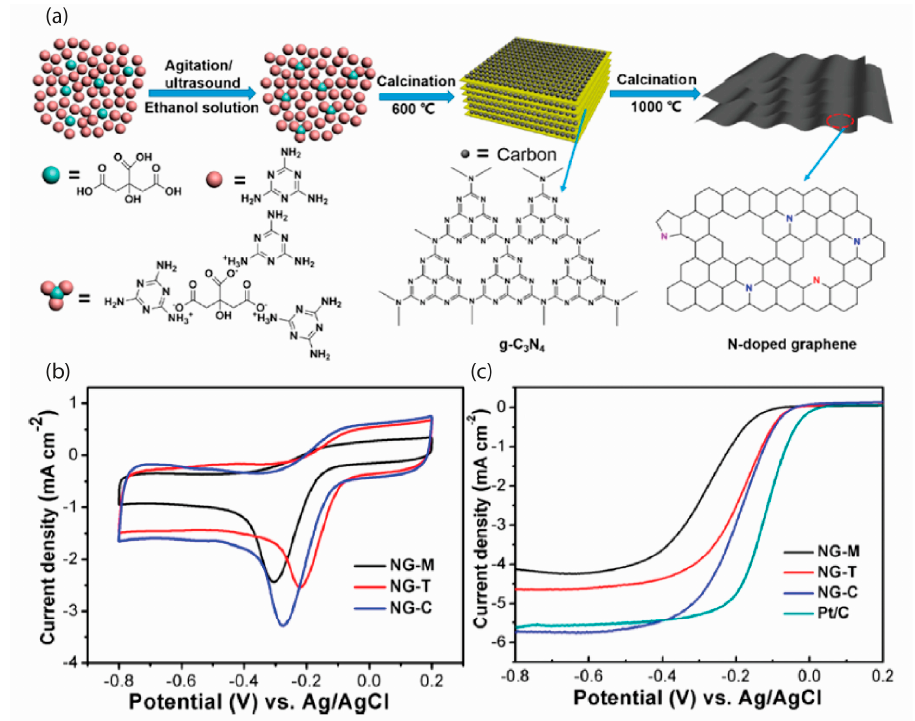
Figure 2. ( a ) Proposed synthetic protocol for N-doped graphene. ( b ) CV plots of NG-M, NG-T, and NG-C. ( c ) LSV curves of ORR on NGs and commercial Pt/C at a scan rate of 5 mV/s at 1600 rpm. (Reprinted from reference [50] with permission from the American Chemical Society. Copyright 2015).